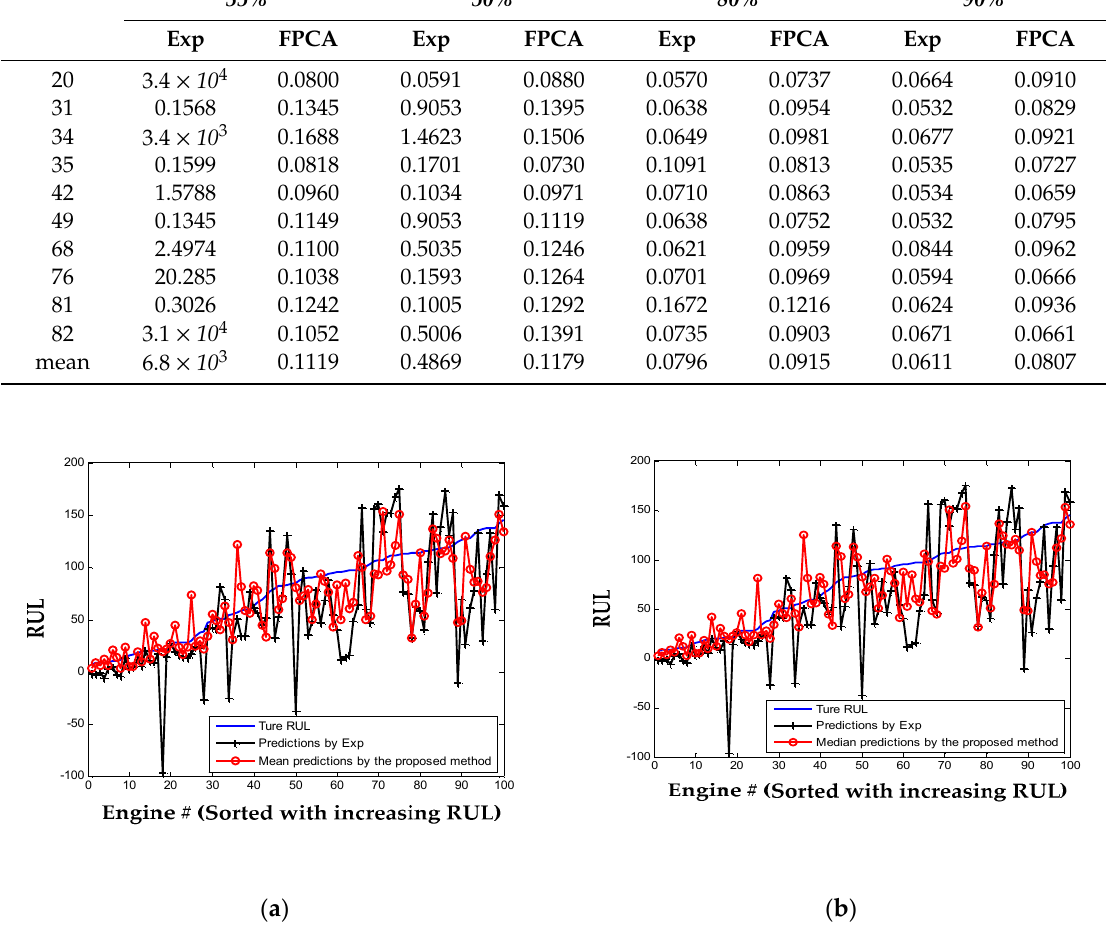
Figure 10. Remaining useful life (RUL) predictions for the 100 testing engines: ( a ) the mean by the